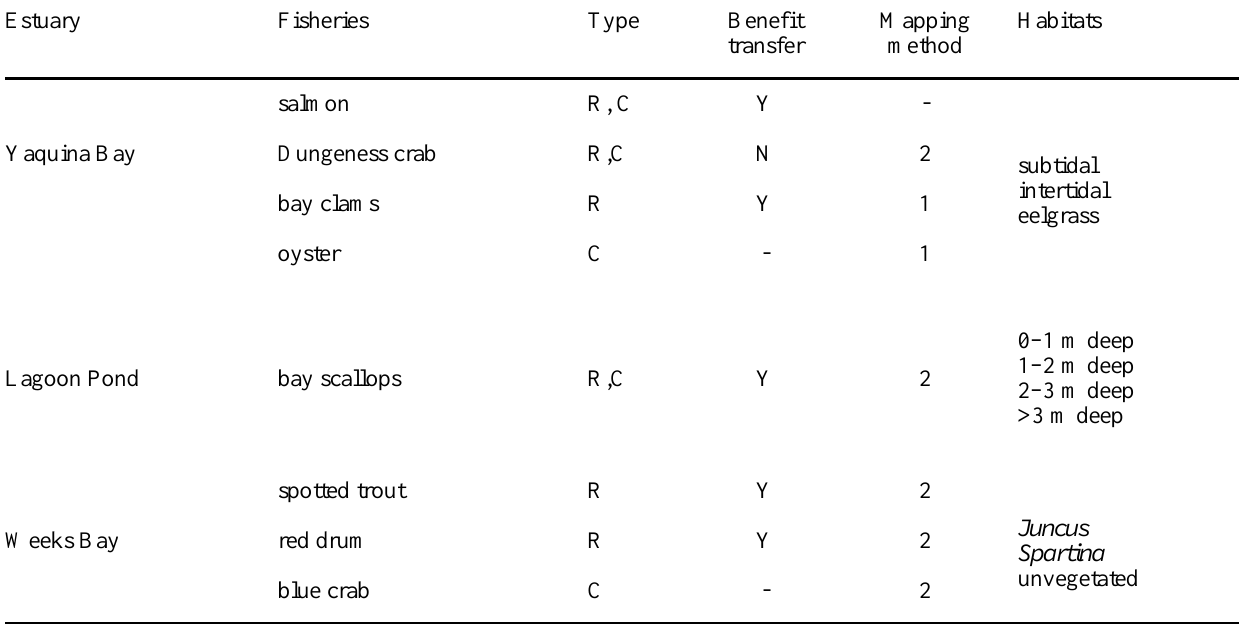
Table 1. Summary of the fisheries evaluated, type of fishery (R=recreational, C=commercial), use of benefit transfer for recreational valuation (Y=yes, N=no), mapping method, and habitat types occurring in each